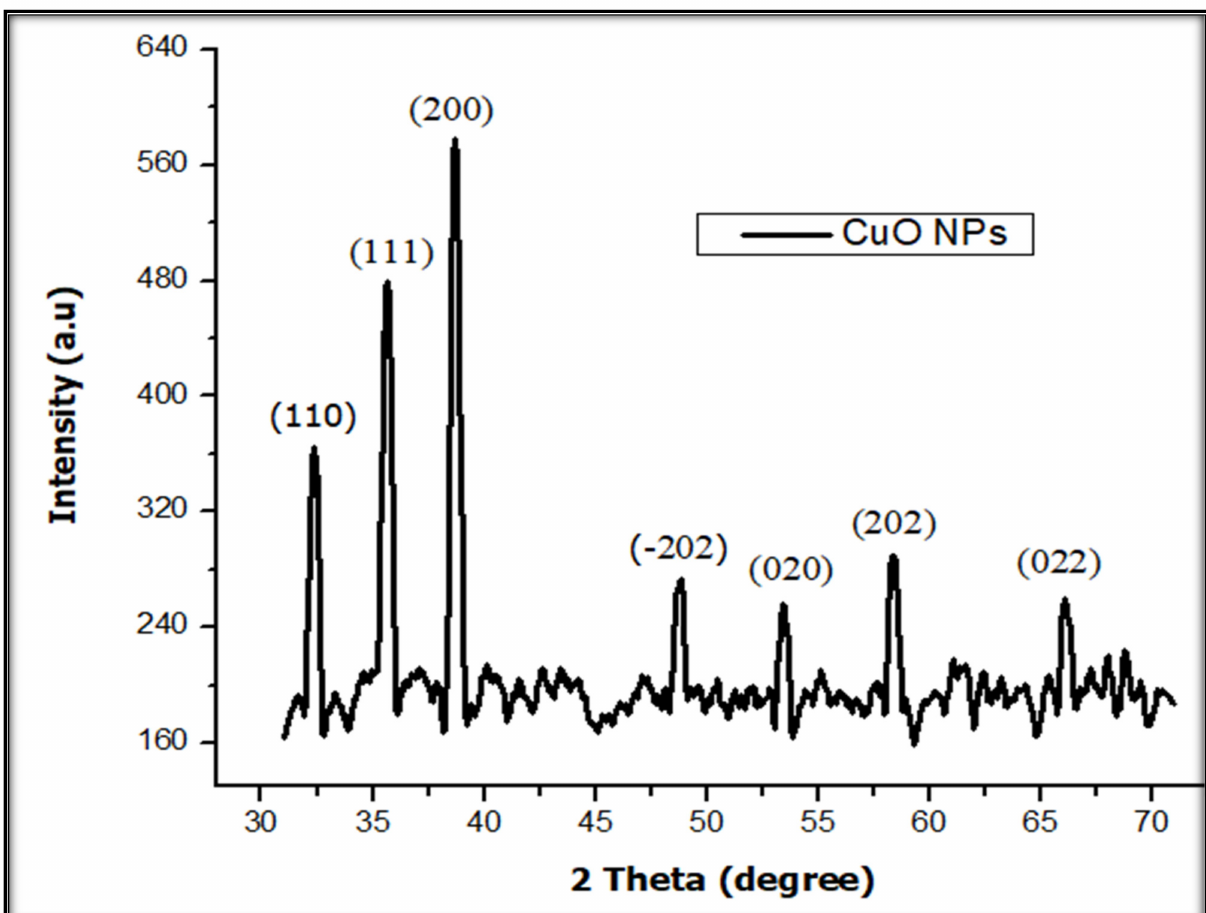
CuO NPs that have been produced are seen in Figure 7 XRD diffraction patterns. The XRD pattern is plotted between 2 theta ( θ ) and intensity. 2 θ = 32.34, 35.64, 38.69, 48.70, 53.47, 58.35, and 66.12 are assigned to (110), (111), (200), ( − 202), (020), (202), and (022) reflection lines, respectively of crystalline CuO nanoparticles that are in correct agreement with the results reported (Sarker et. al., 2020) [48].